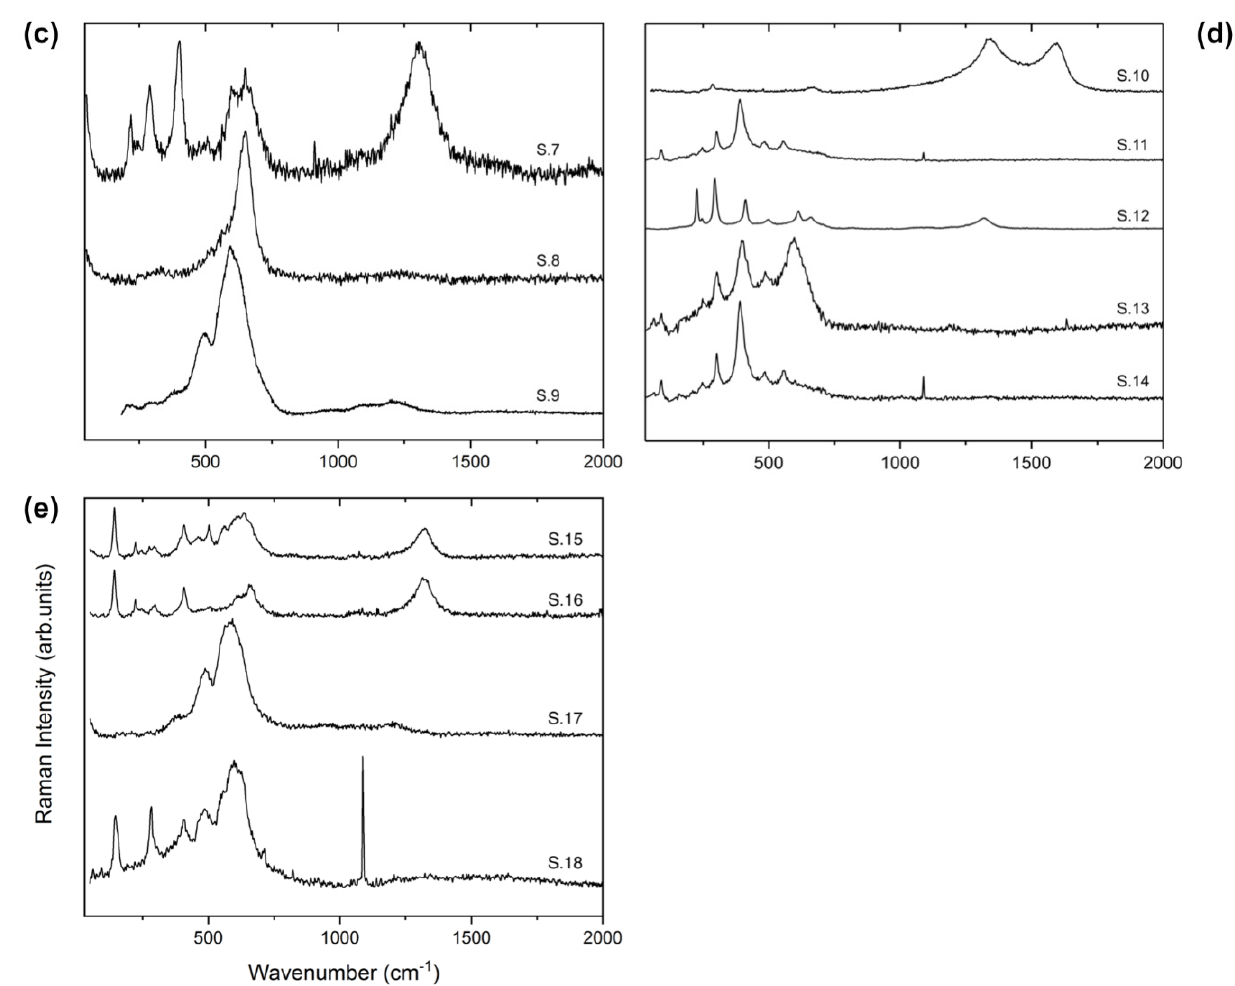
Figure 3. Raman spectra of sediment samples: ( a ) sediment #1, with the inset reporting an example of the anatase filtering of the E g peak in the calcite spectrum (the shoulder at ca. 143 cm − 1 highlighted with * is due to the contribution of the E g mode of anatase); ( b ) sediment #2; ( c ) sediment #3; ( d ) sediment #4; and ( e ) sediment #5. All the spectra were collected using the DXR2 as discussed in the text, whilst the spectrum S.9 (panel c ) was acquired by means of LabRam HR-800 at 0.01 mW to test and avoid any mismatch with the spectra collected with DXR2.